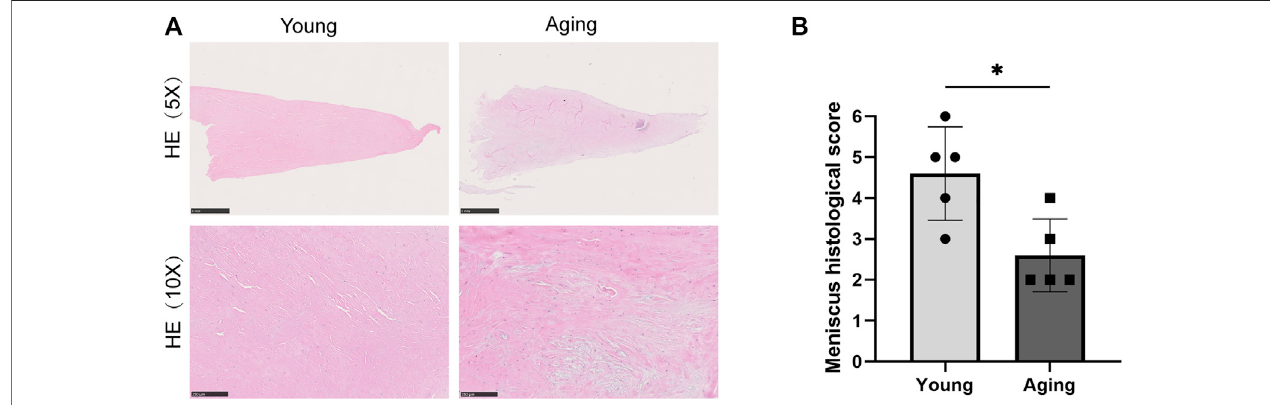
FIGURE 1 | Histology staining. (A) Representative HE stain of meniscus tissue in old and young group. Scale bar = 1 µm in upper and 200 µm in lower. (B) Rodeo score system was used to assess tissue histological features. * p < 0.05 vs. control, n =